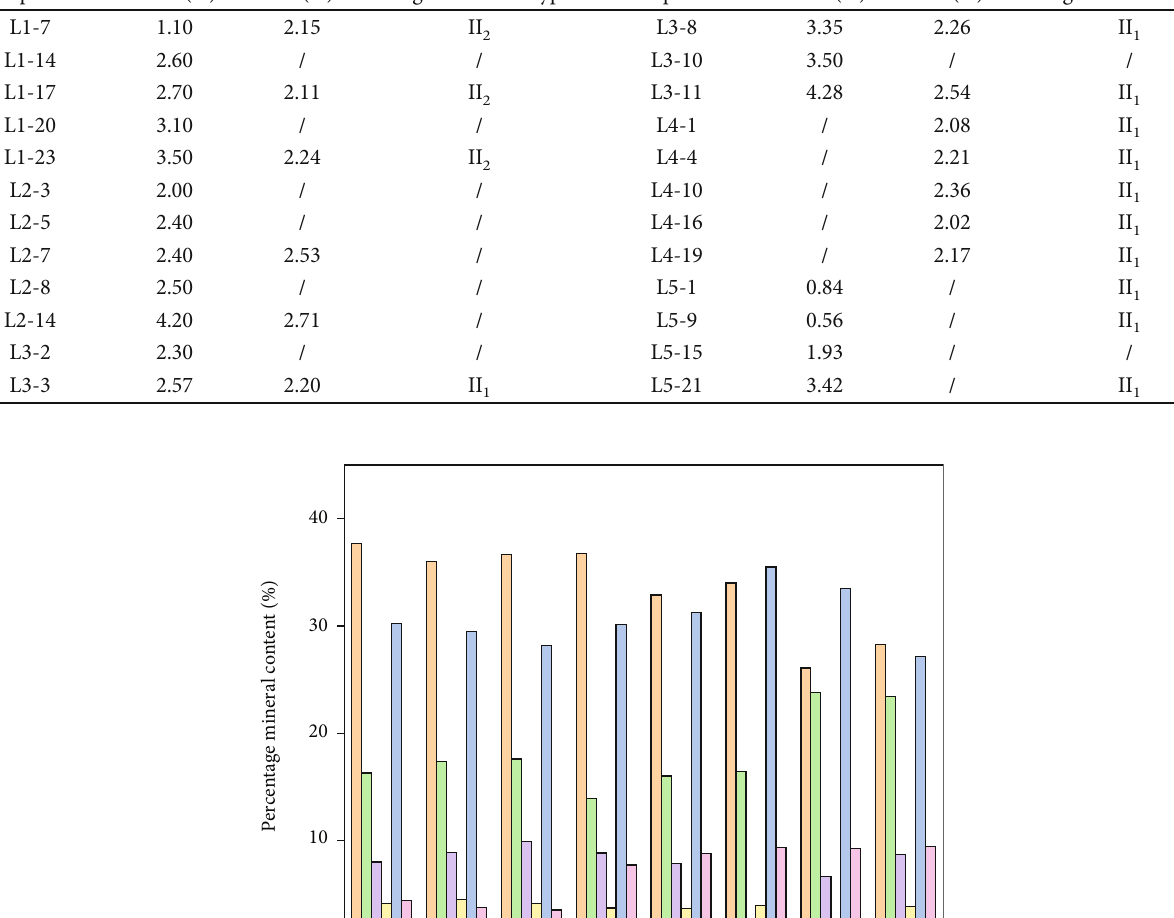
Table 1: TOC, Ro , and organic matter types of the LF in the study area. SampleNo.